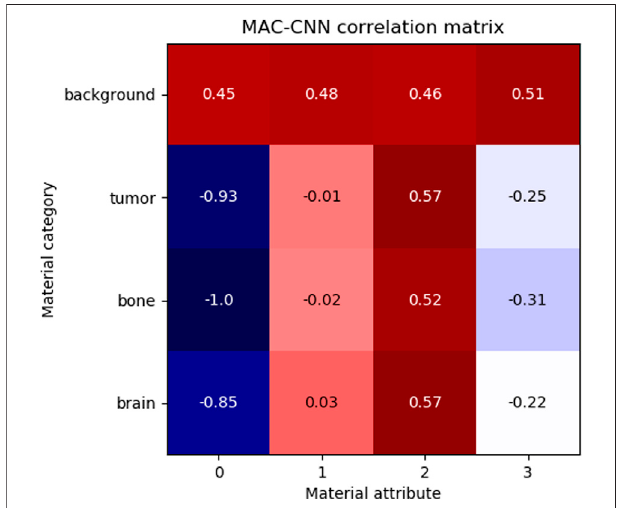
FIGURE 7 | The correlation of MAC-CNN categorizations between material categories and material attributes. The most strongly exhibited association is with attribute 0 and the background category, which may be attributabletoitshomogeneityasthenullcategory.Attributes1and2do not greatly separate the brain and tumor material categories, likely due to their small perceptual